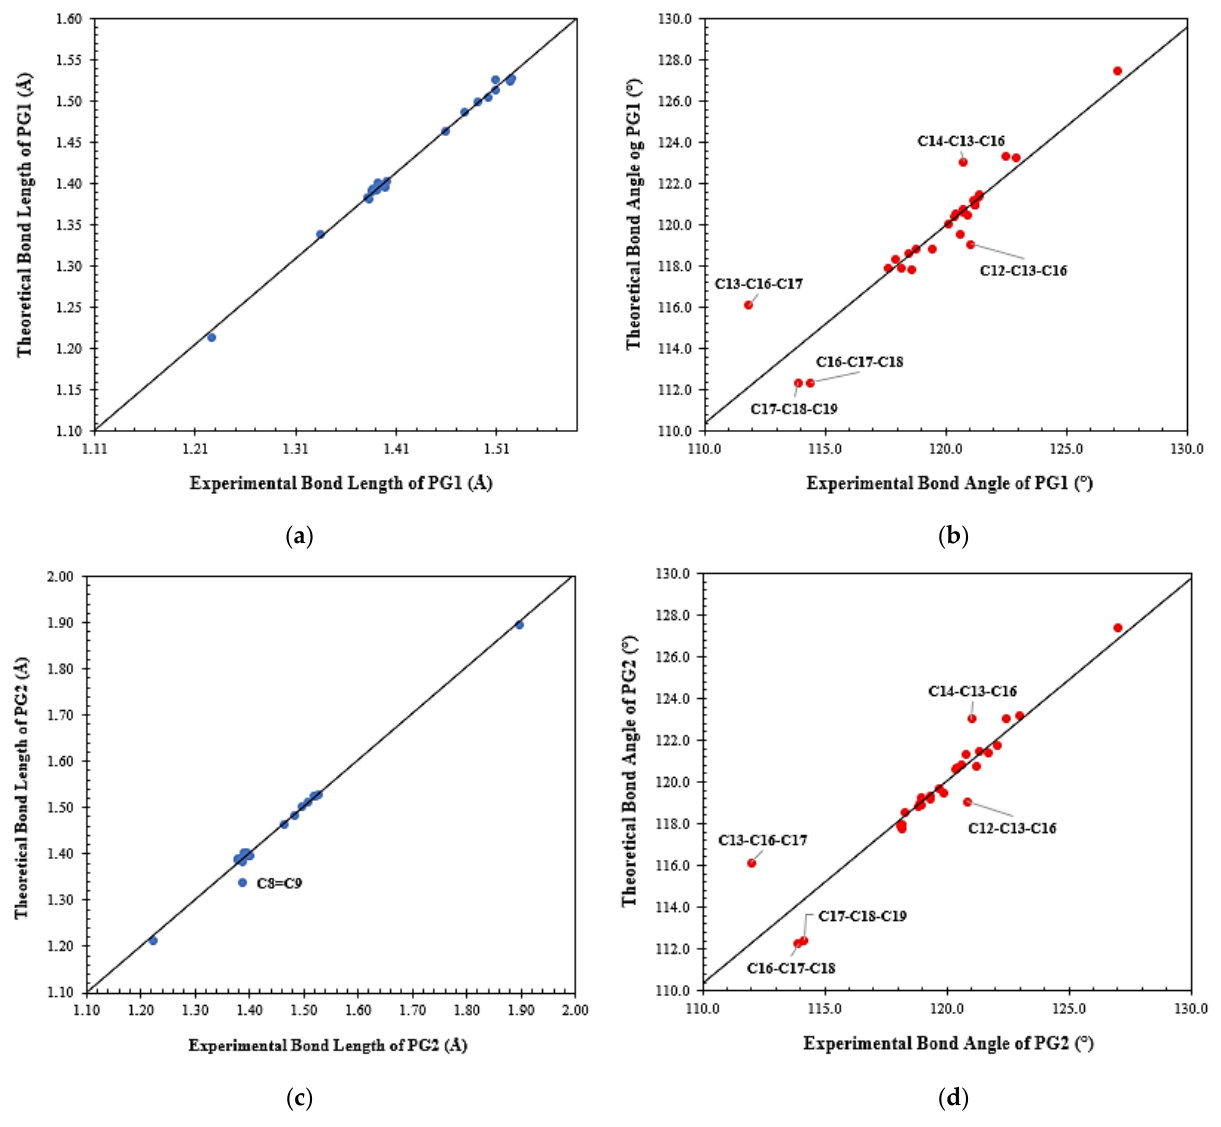
Figure 4. Scatter plots comparing experimental and theoretical values of bond lengths ( a , c ), and bond angles ( b , d ) in BMP and BBP chalcones.